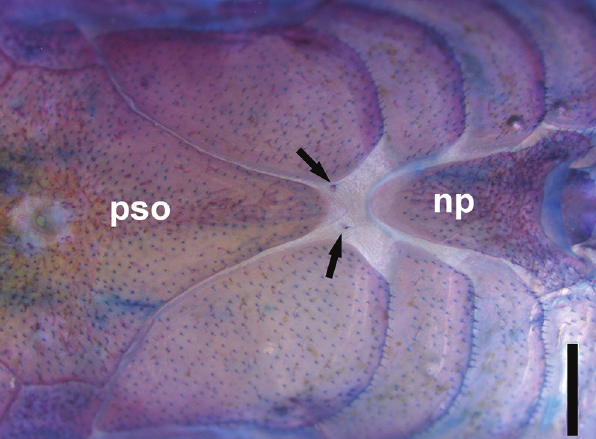
Fig. 3. Aspidoras kiriri , NUP 18246, c&s paratype, 30.4 mm SL, showing anterodorsal portion of body. Arrows indicate small platelets. Abbreviations: np: nuchal plate, pso: parieto- supraoccipital. Scale bar = 1